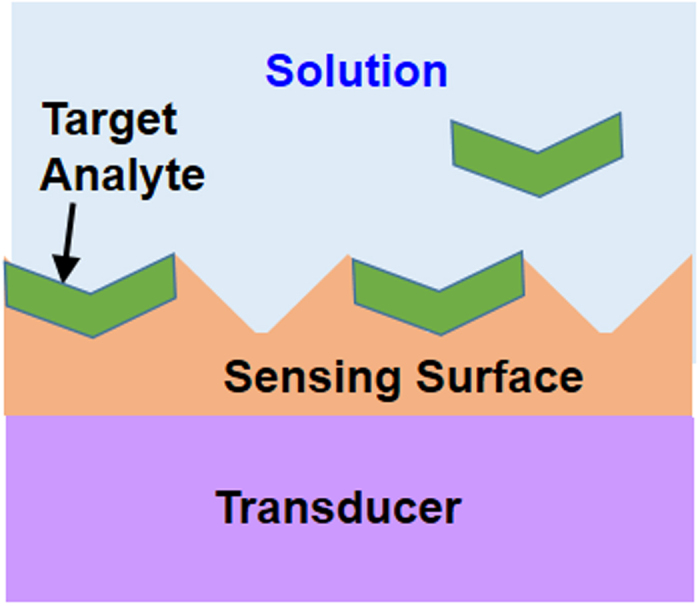
An electrochemical sensor schematic.Sensor components are shown: sensing surface and transducer; the sensing surface is in contact with the solution with dissolved target analyte that selectively bind to the sensing surface.